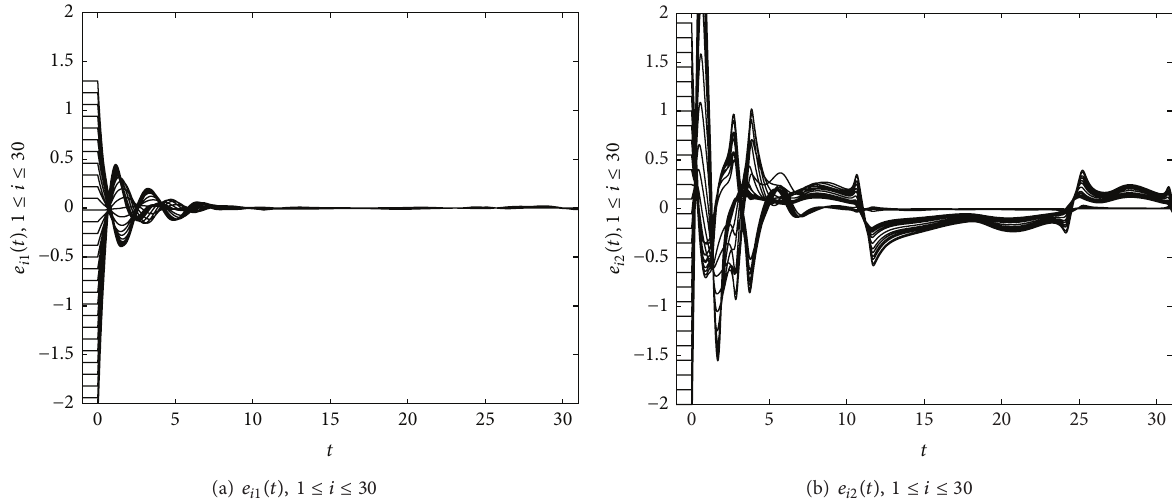
Figure 11: Synchronization errors between (39) and (36) by using adaptive controllers (26).